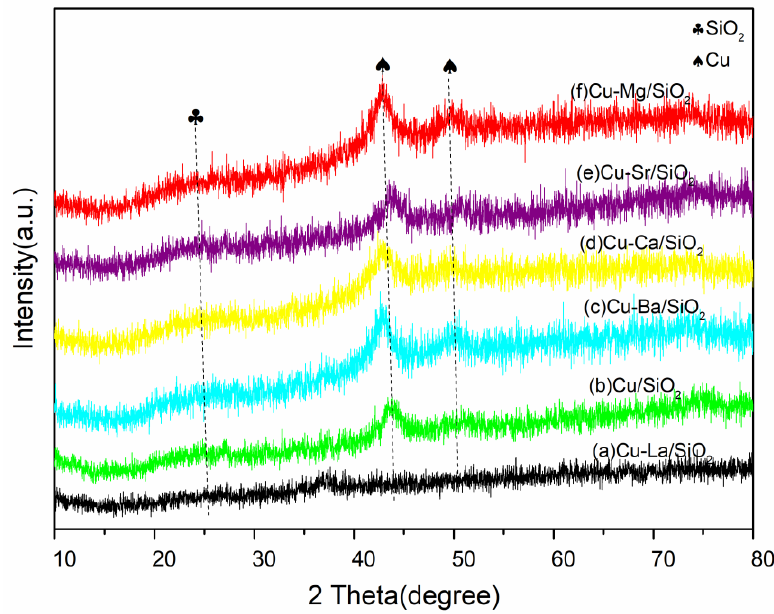
Figure 1. In situ XRD patterns of the calcined catalysts: ( a ) Cu-La / SiO 2 ; ( b ) Cu / SiO 2 ; ( c ) Cu-Ba / SiO 2 ; ( d ) Cu-Ca / SiO 2 ; ( e ) Cu-Sr / SiO 2 ; ( f ) Cu-Mg / SiO 2.